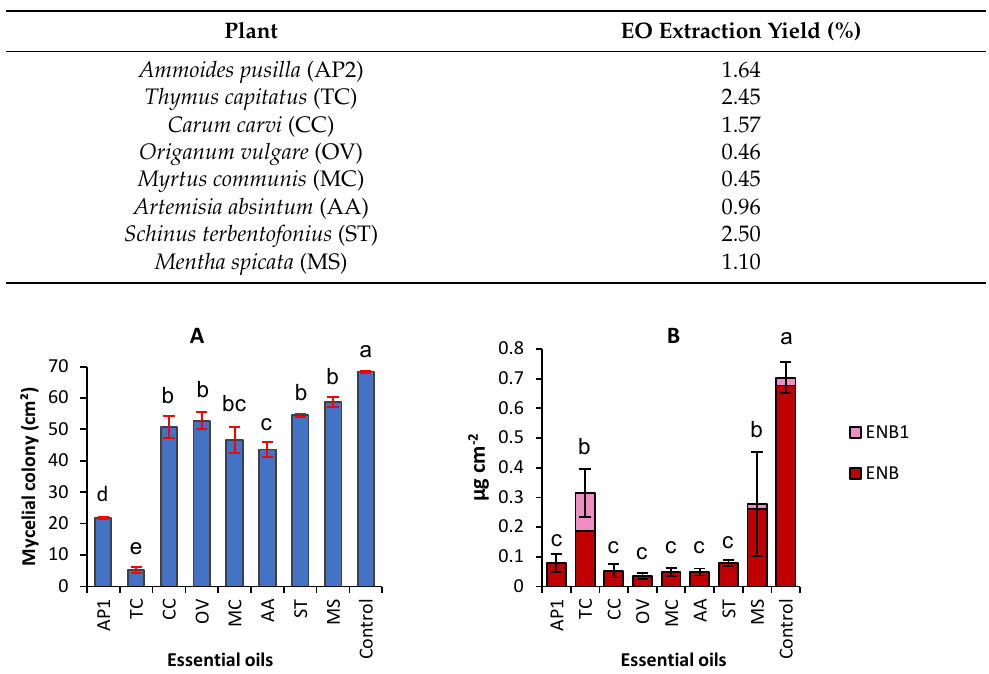
Table 2. Extraction yield of essential oils from eight Tunisian aromatic plants.